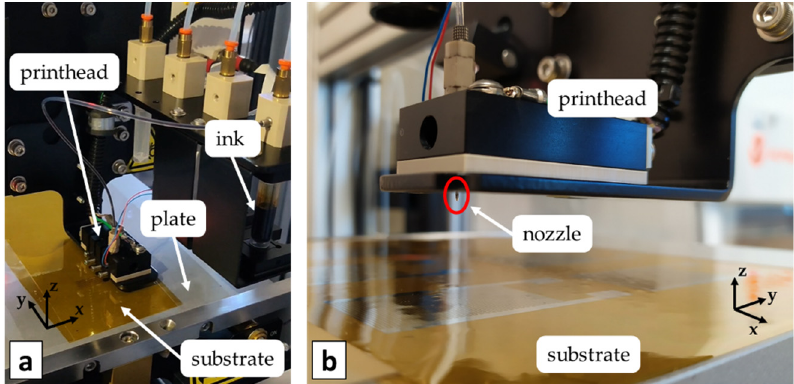
Figure 2. ( a ) MicroFab Jetlab 4xl printer; ( b ) Detail of the printhead with the nozzle. The interdigital geometry is printed as a combination of several drop arrays. The printing direction corresponds to the main length of the array that is the x-direction (Fig- ure 1).